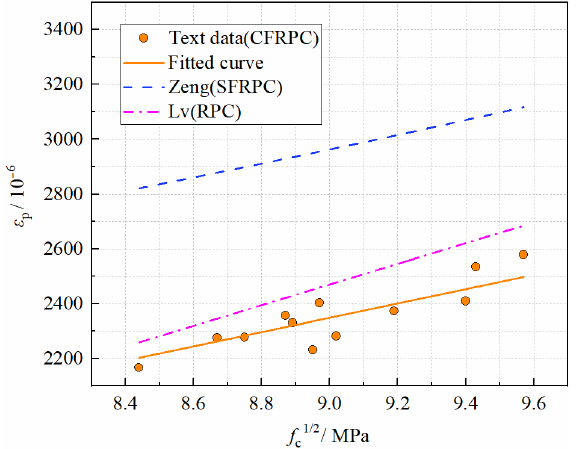
Figure 25. Relationship ε p vs. f c.